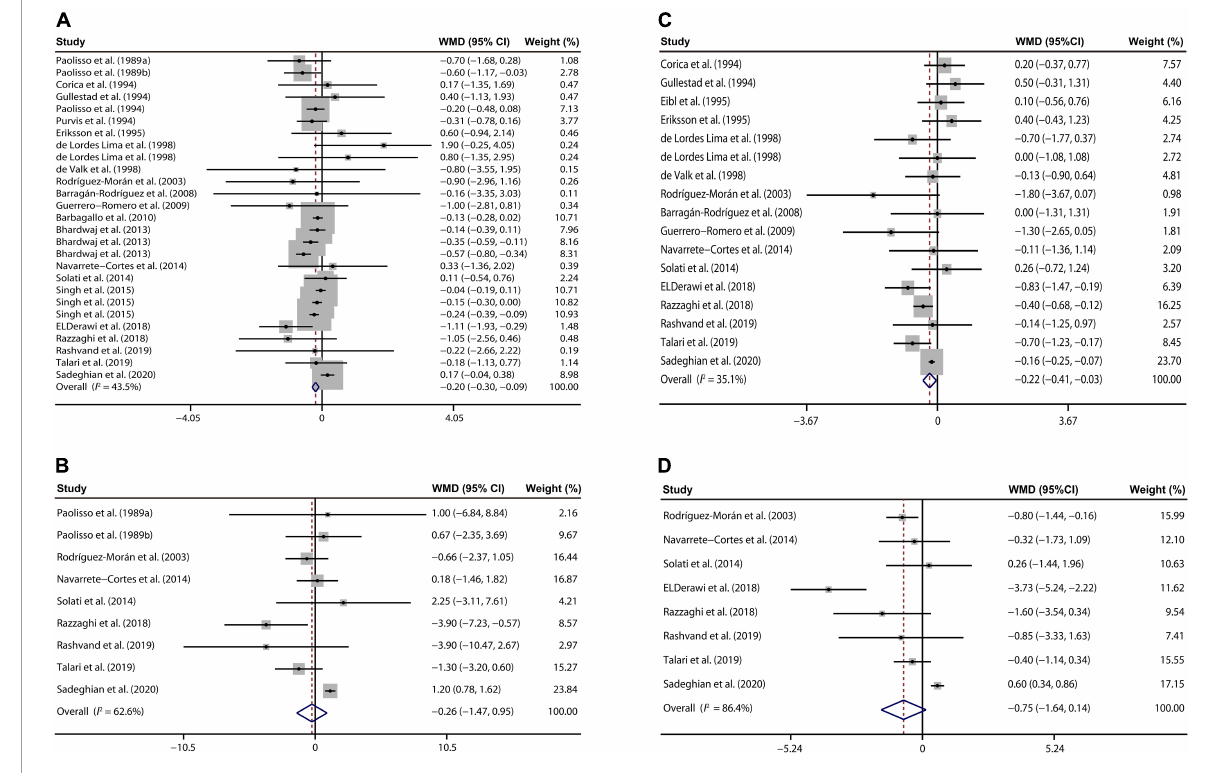
FIGURE2 Forest plots for the effects of magnesium supplementation on FPG (A) , insulin (B) , HbA1c (C) , and HOMA-IR (D) compared to controls in pooled analysis. For each study, the solid black circles represent the point estimate of the intervention effect. The horizontal line joins the lower and upper limits of the 95% CI of this effect. The open diamonds represent the overall WMD determined with a random-effect model. FPG, fasting plasma glucose; HbA1c, glycated hemoglobin; HOMA-IR, homeostasis model assessment-insulin resistance; WMD, weighted mean